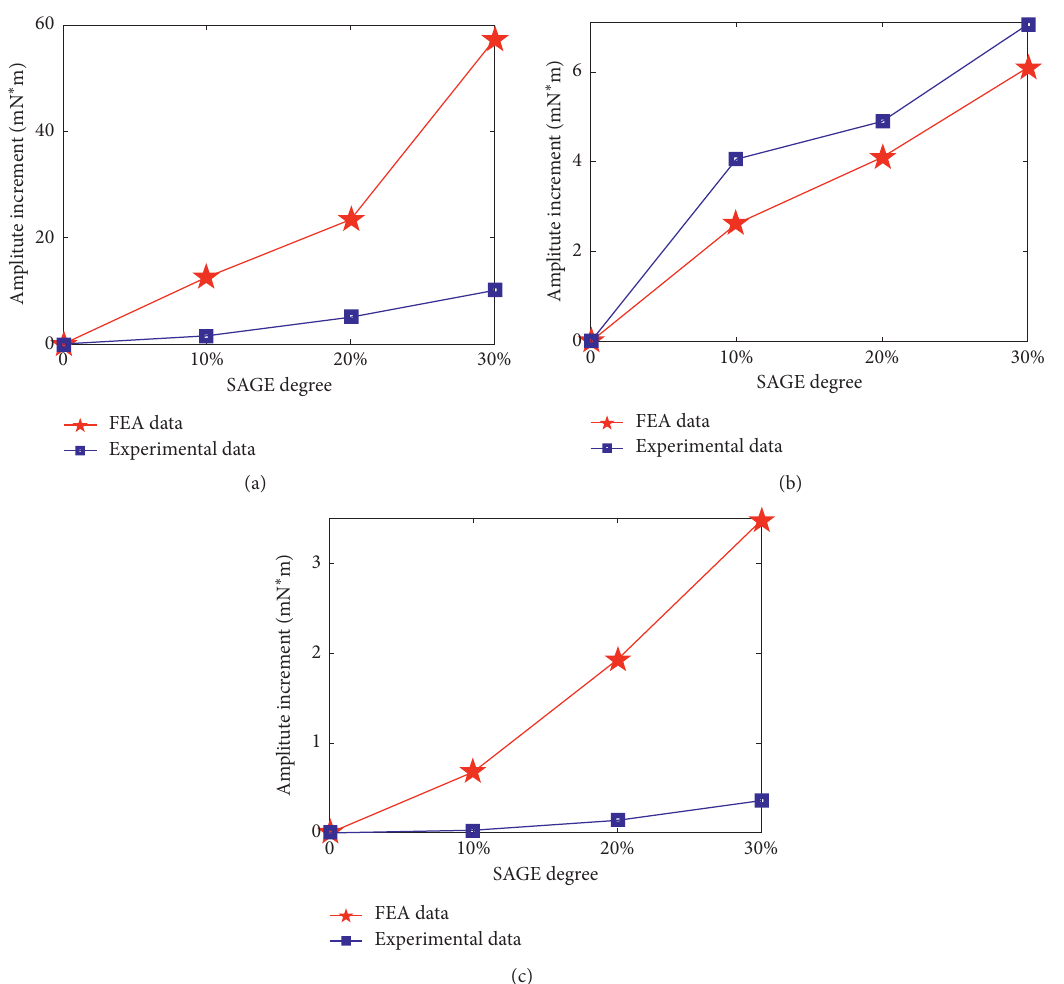
Figure 8: FEA and experiment comparison in SAGE cases: (a) 2nd harmonic, (b) 4th harmonic, and (c) 6th